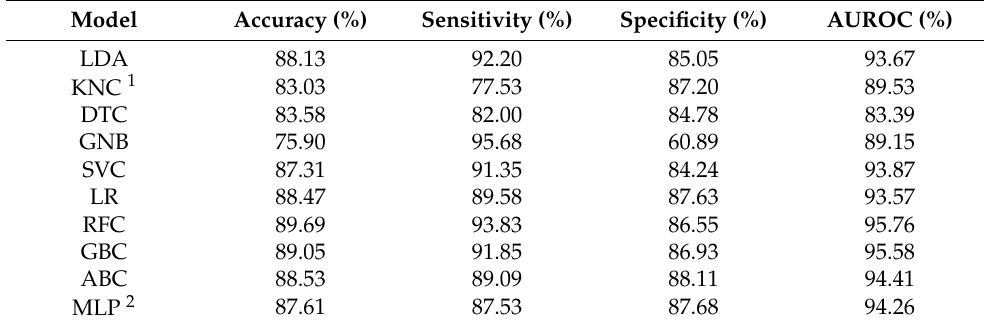
Table 1. Performance of ML models in predicting cardiovascular events and treatments, including CABG, PCI, VS, stroke, and MI.